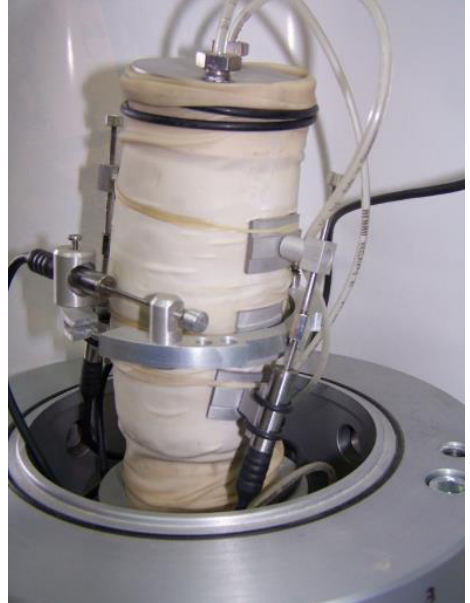
Figure 5. Sample of weak clay destroyed during the mounting of the sensors for strain measurement (source: photo of Jastrzębska M., after [41]; available via 2021 Civil and Environmental Engineering’s permission).